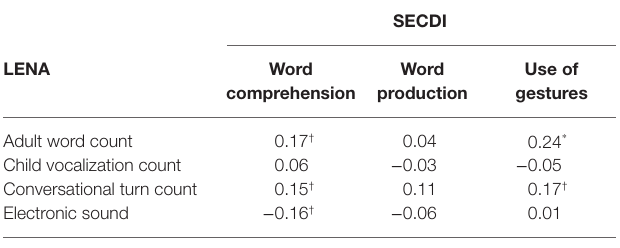
TABLE 2 | Coefficients of the Pearson’s intercorrelations between LENA and Swedish Early Communicative Development Inventory